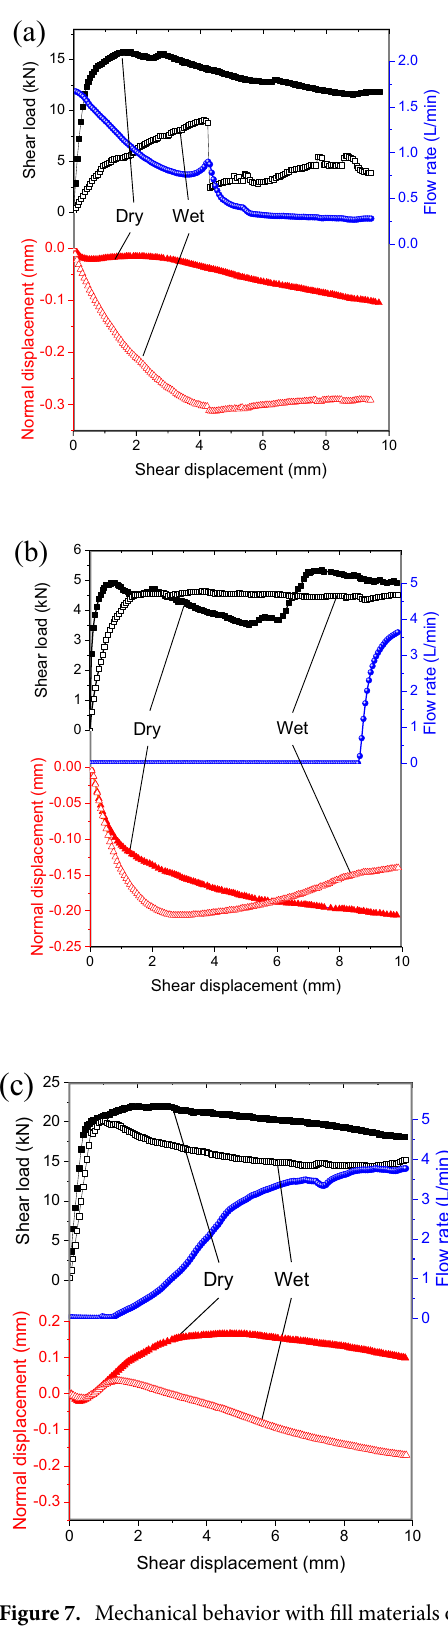
Figure 7. Mechanical behavior with fill materials of ( a ) sand, ( b ) clay and ( c )